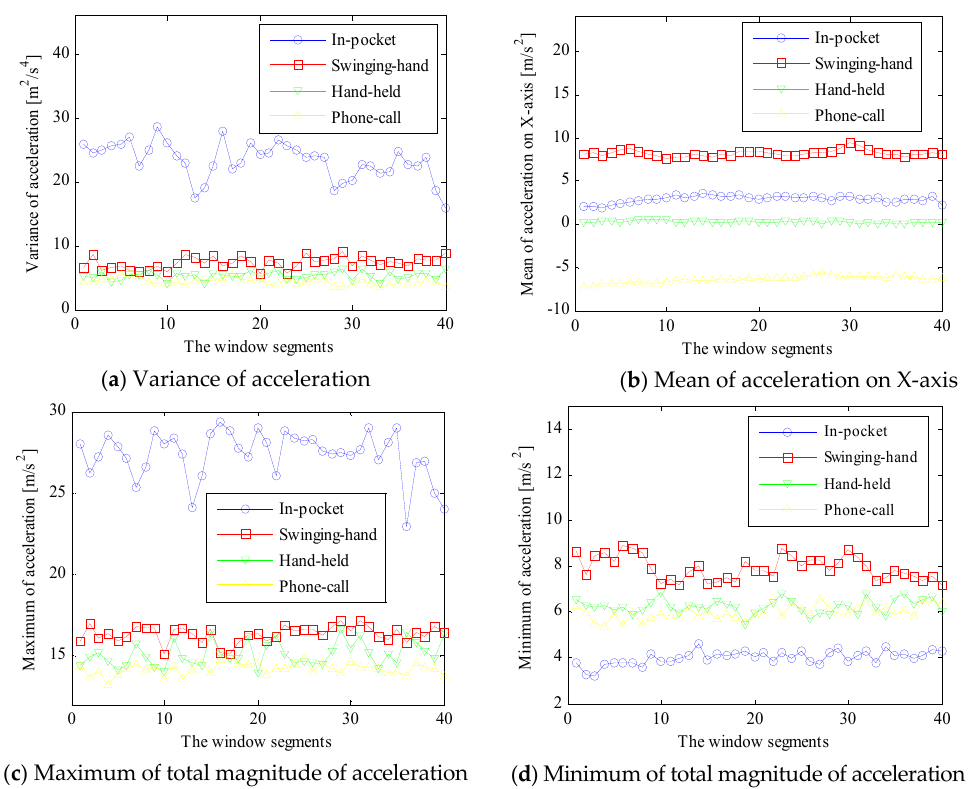
Figure 3. Feature comparisons with different carrying positions.